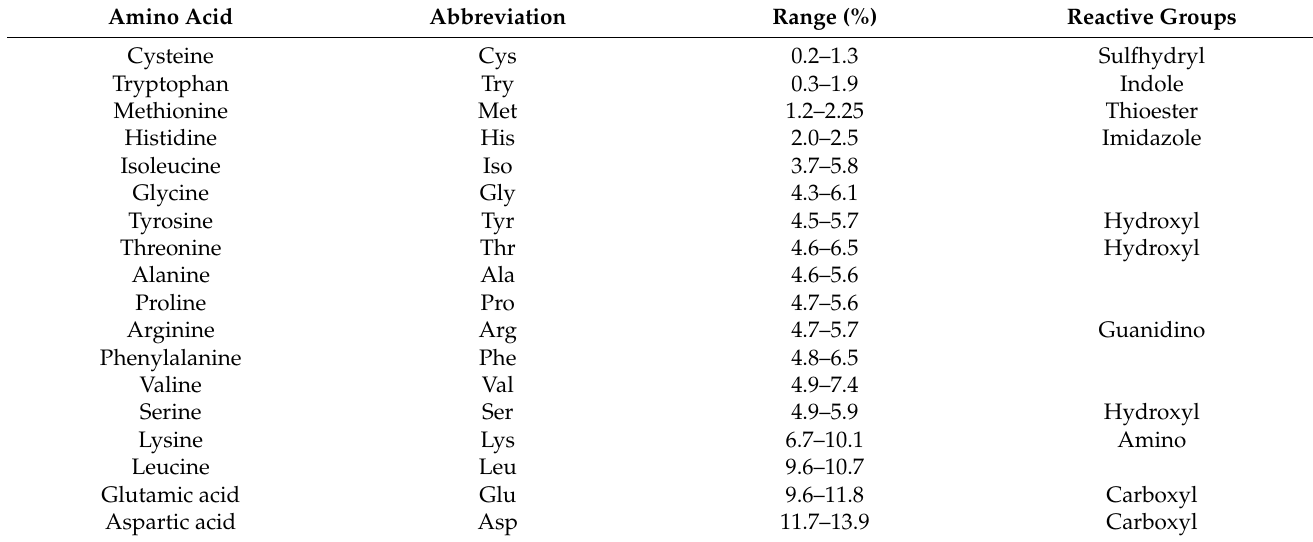
Table 1. Amino acid composition of potato protein with the reactive groups of their side chains, ordered from the smallest to biggest fraction (adopted and extended from